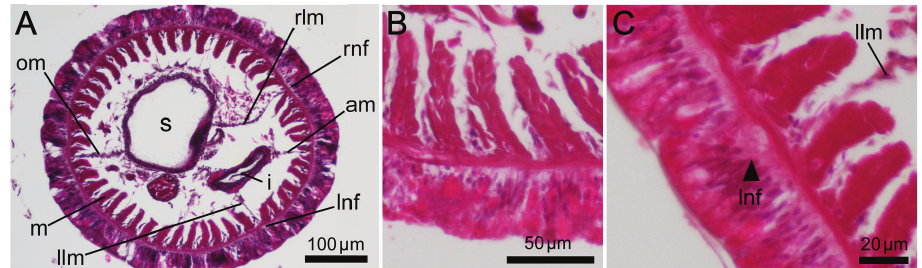
Figure 6. Phoronis ijimai . A NSMT-Te 886, transverse section through the posterior part of the body, showing four mesenteries and the position of the giant nerve fibers B NSMT-Te 885, enlargement show- ing longitudinal muscles of the bushy type C NSMT-Te 885, enlargement of the left giant nerve fiber situated at the base of the left lateral mesentery. Abbreviations: am anal mesentery; i intestine; llm left lateral mesentery; lnf left giant nerve fiber; m longitudinal muscle; om oral mesentery; rlm right lateral mesentery; rnf right giant nerve fiber; s stomach.